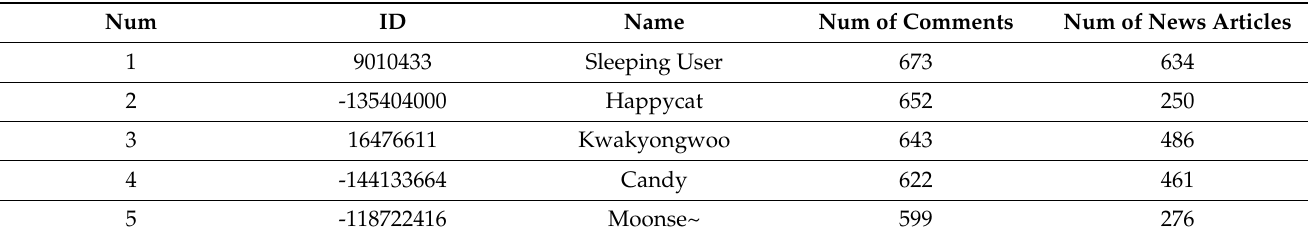
Table 2. User data for top 5 commenters.